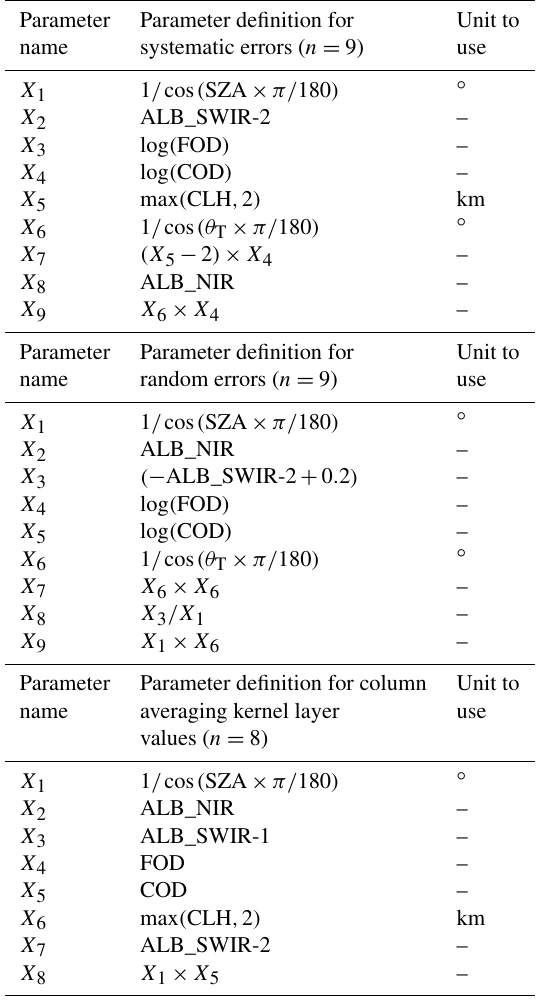
Table 4. Heuristically determined parameters to use for L2 perfor- mance